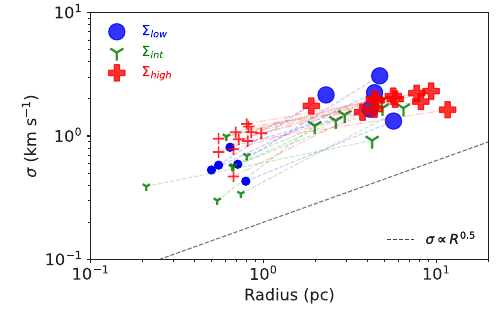
Figure 1. Larson relation for the clumps and the parent filaments belonging to the three groups. The dotted lines connect each clump (left-hand points) with the parent filament (right-hand points). Objects associated with clumps in the Σ lo w , Σ int and Σ hi g h groups are represented as blue circles, green tri_downs and red crosses, respectively. The black-dotted line is the σ R 0 . 5 relation in ∝ the case of a supersonic turbulent cascade of energy from large down to small scales